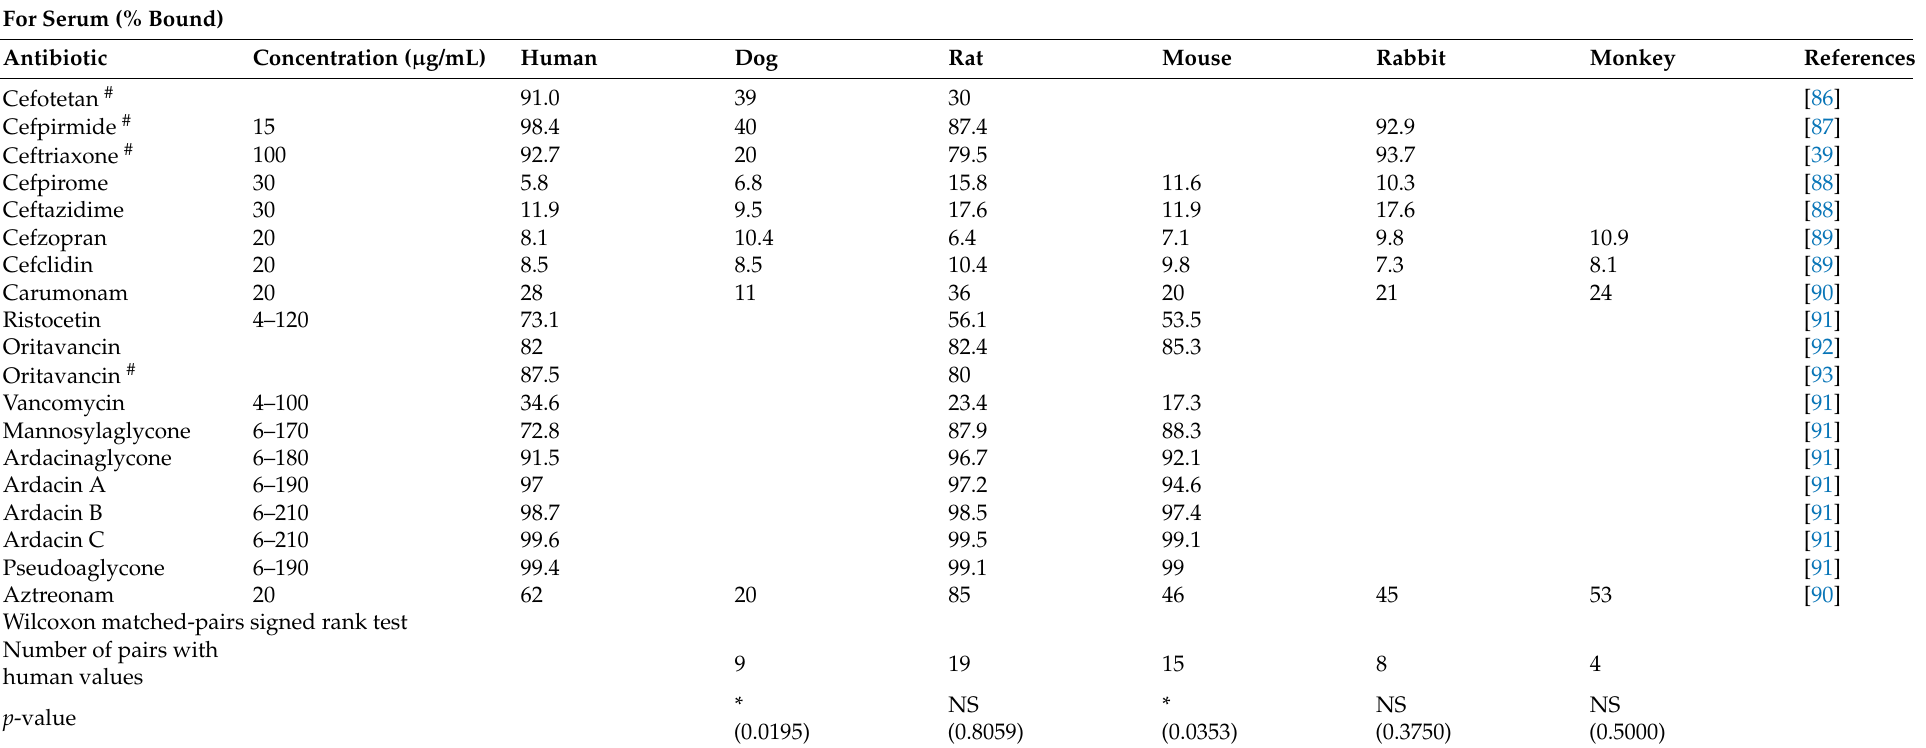
Table 3. Interspecies comparison of protein binding in serum and plasma. Wilcoxon matched-pairs signed rank test was performed between antibiotics percentage unbound in human and other species. p -Value < 0.05 is considered as